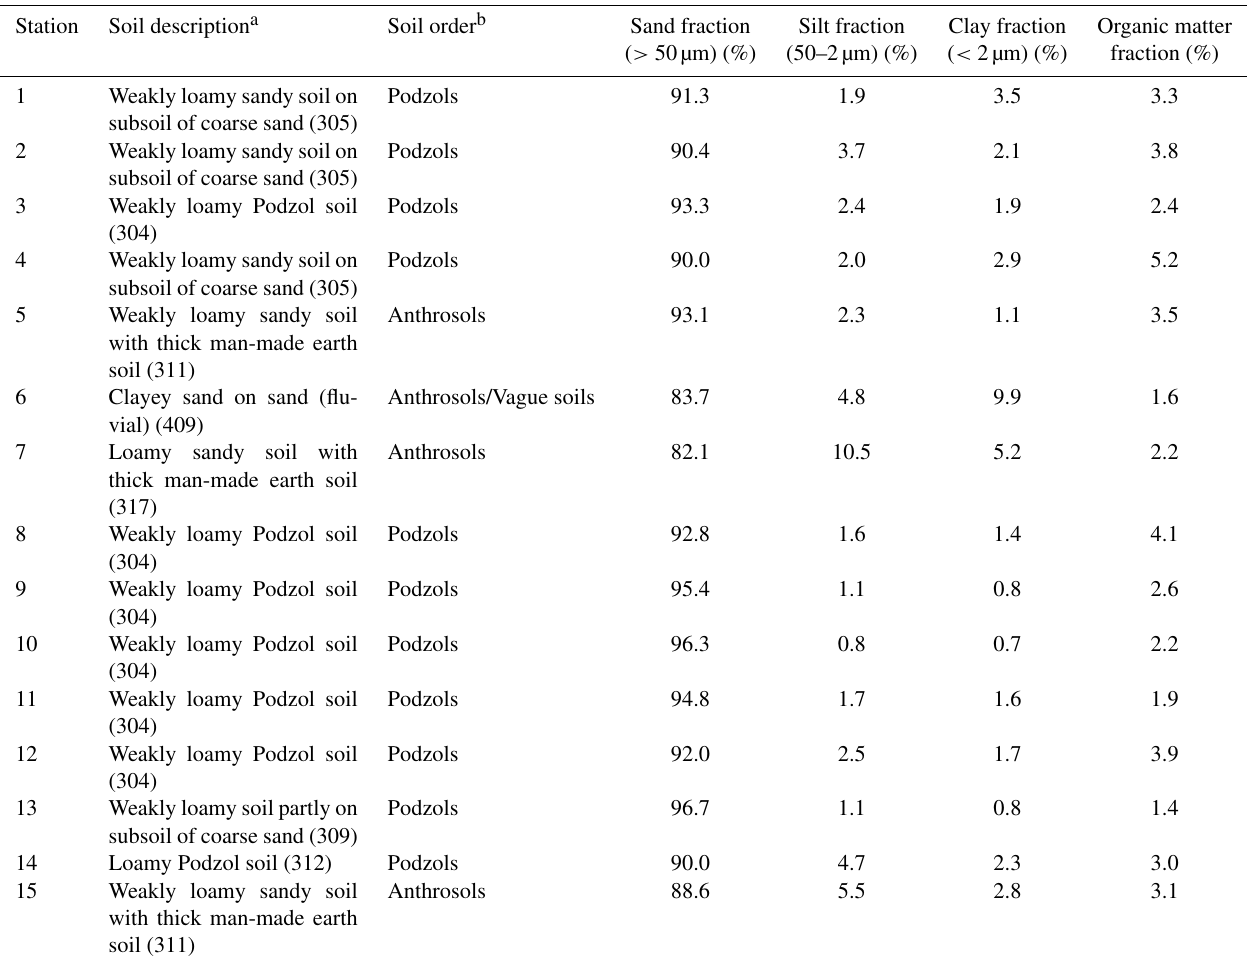
Table 2. Characteristics of the soil moisture monitoring